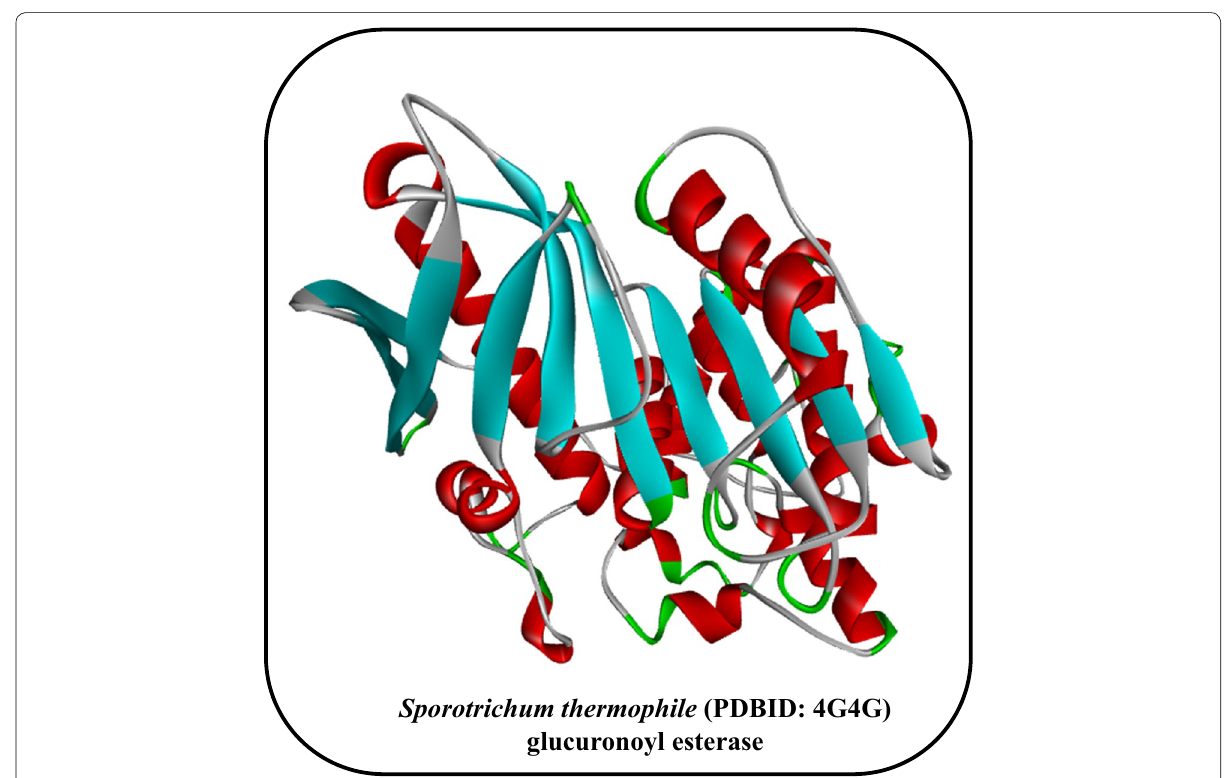
Fig. 6 The protein secondary structure of Sporotrichum thermophile glucuronoyl esterase (carbohydrate esterase class-I) (PDB ID:4G4G) (Charavgi et al. 2013), where alpha-helices (red), beta strands (blue) and coils (gray). (Image was developed using Discovery Studio Visualizer ®